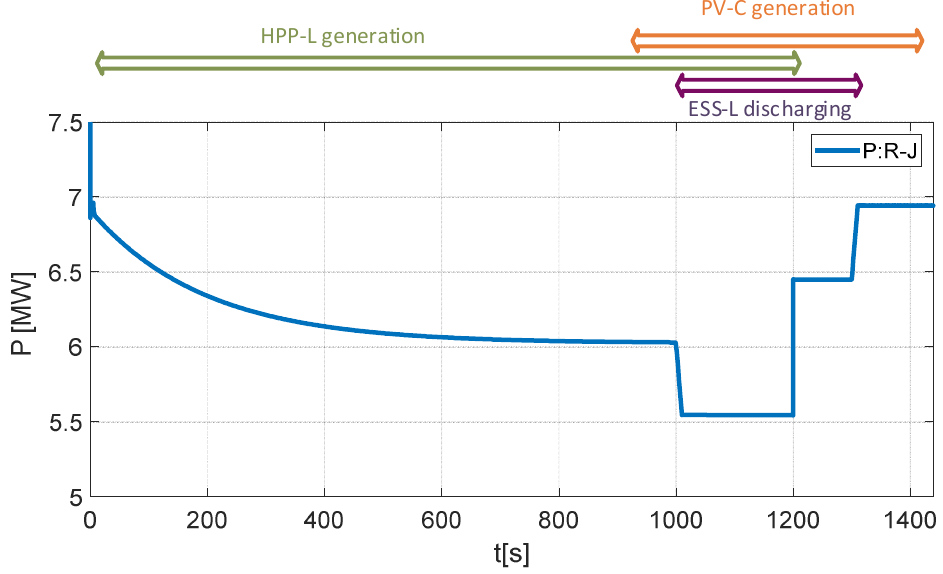
Figure 7. Active power changes P in the high voltage / medium voltage (HV/MV) transformer in the main station R-J during the series of switching operations of HPP-L , PV- C and ESS-L .